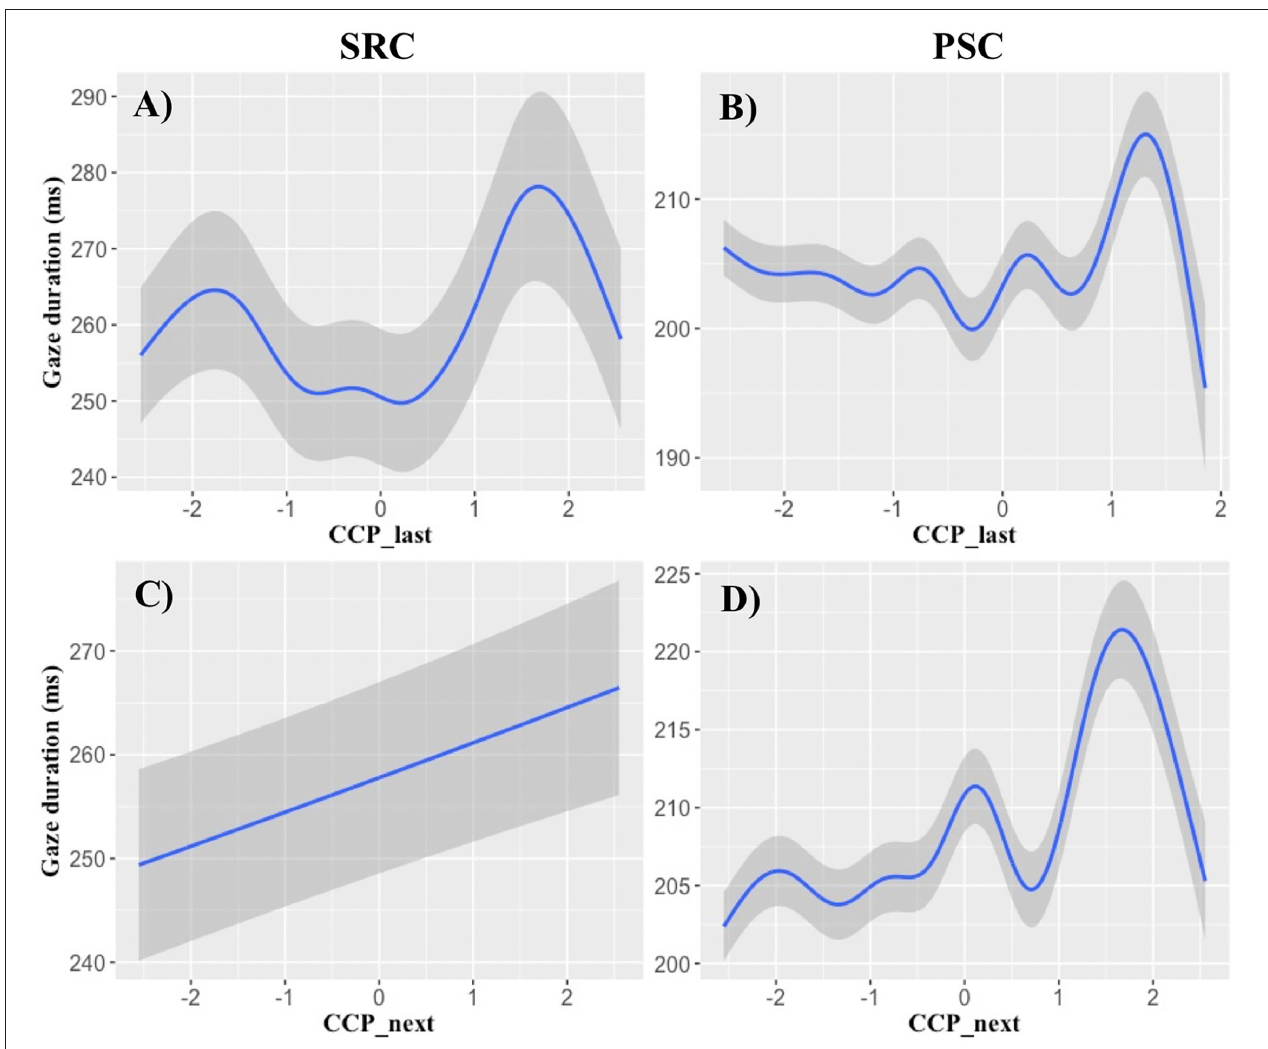
FIGURE 1 | Cloze completion probability effects on gaze duration. The x-axes show logit-transformed cloze completion probability (CCP), while the y-axes demonstrate its influence on gaze durations (ms) of the full GAM models (cf. Table 8 ). (A,B) Illustrate effects of last-word CCP on gaze durations of the currently fixated word. (C,D) Demonstrate that the CCP of the next word has an influence on the gaze durations of the currently fixated word. (A,C) Display effects in the SRC data set and (B,D) illustrate the results of the PSC data set. Particularly in a logit-range around 0.5–1.5, the CCP of the surrounding words seems to delay fixations. Shaded areas indicate standard